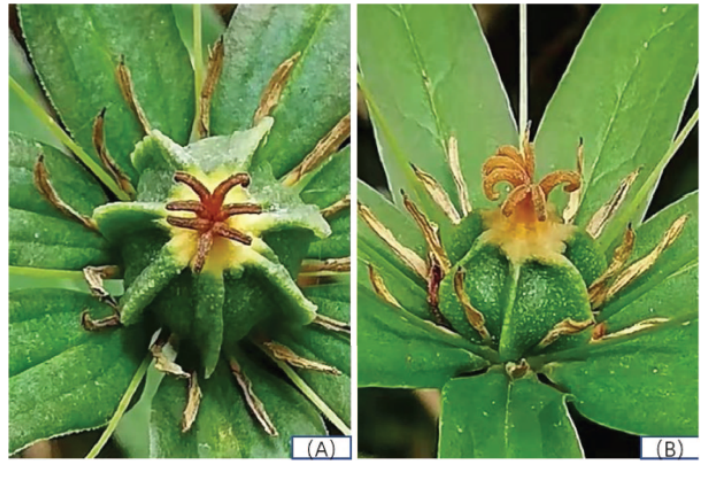
Fig. 4 Paris panxiensis